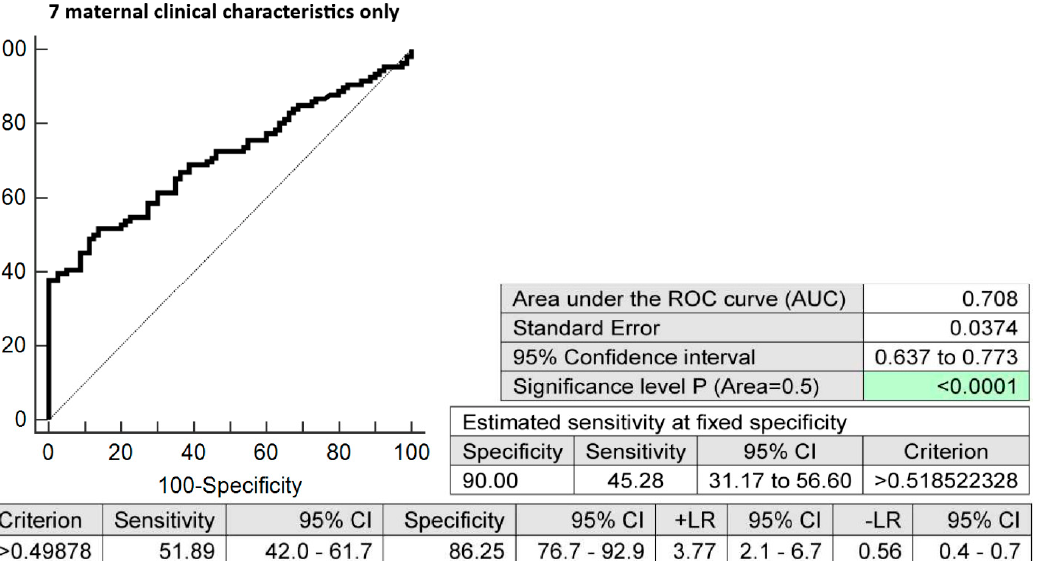
Figure 5. Combination of seven maternal clinical characteristics only (maternal age and BMI values at early stages of gestation, infertility treatment with assisted reproductive technology, the